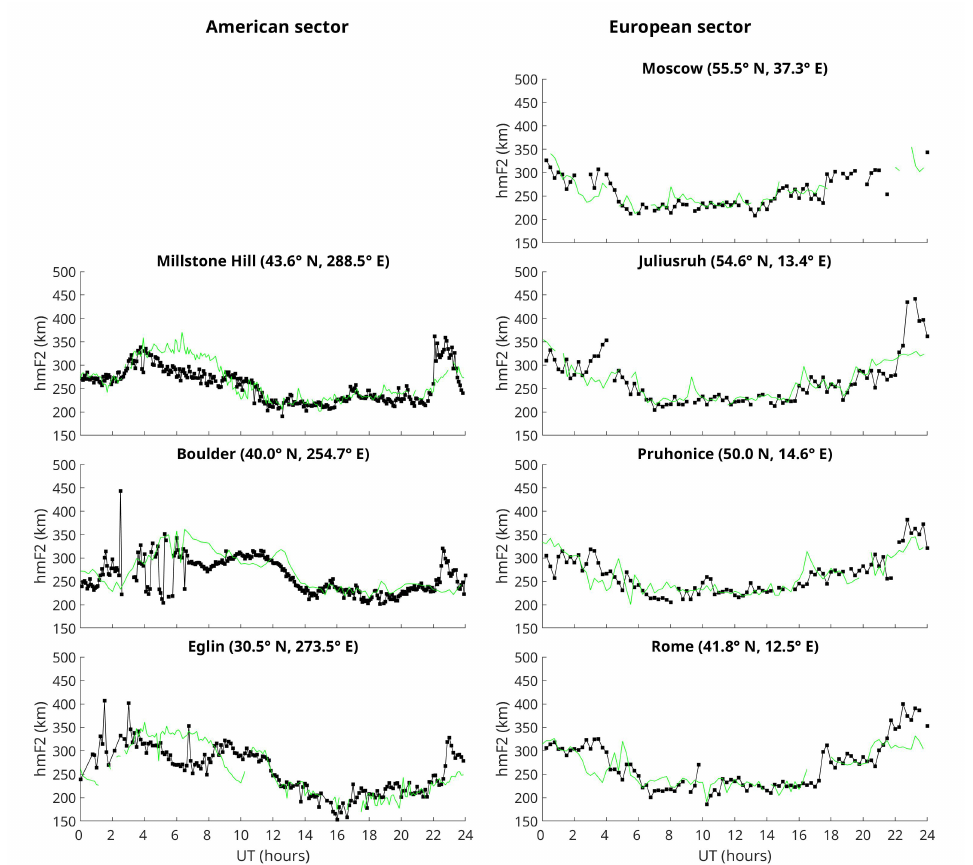
Figure 8. hmF2 observations, on 3 November 2021, in the American sector ( left panels), at Millstone Hill, Boulder and Eglin, and in the European sector ( right panels), at Moscow, Juliusruh, Pruhonice, and Rome. The reference values are shown as green lines (see text for